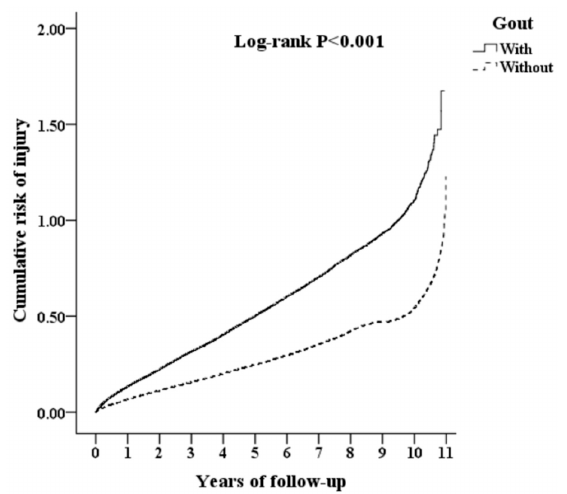
Figure 1. Kaplan–Meier analysis for cumulative risk of injury among patients aged 18 and over stratified by gout with log-rank test.